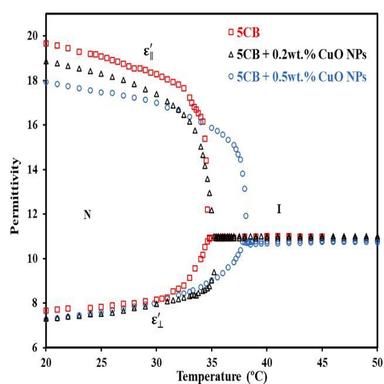
Temperature dependence of longitudinal (ε′ ‖) and transverse (ε′ ⊥) components of permittivity. Squares, triangles and circles show pure 5CB, 5CB + 0.2 wt% CuO NPs and 5CB + 0.5 wt% CuO NPs respectively.